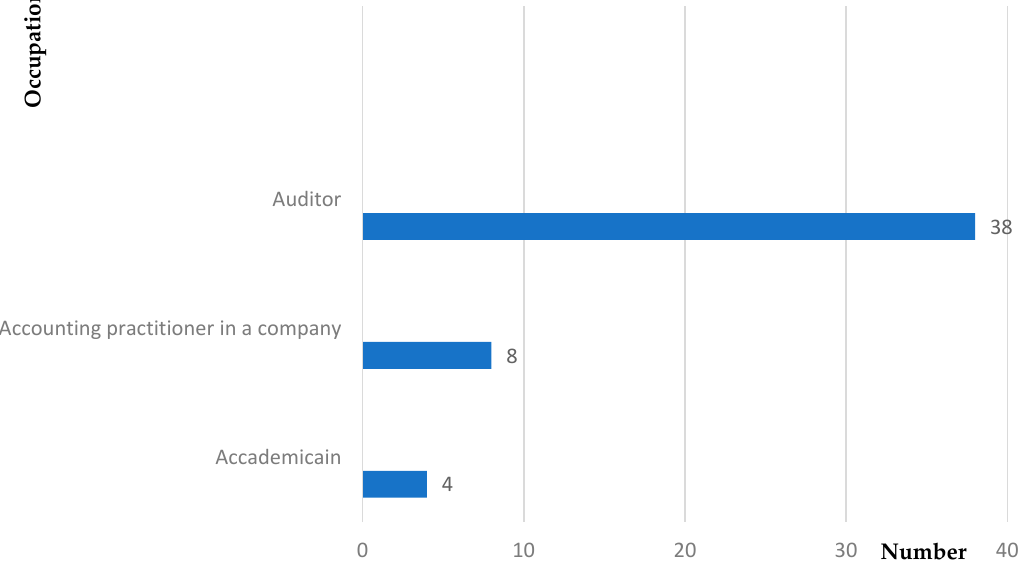
Figure 1. Occupation of the respondents (Source: developed purposely for this research).